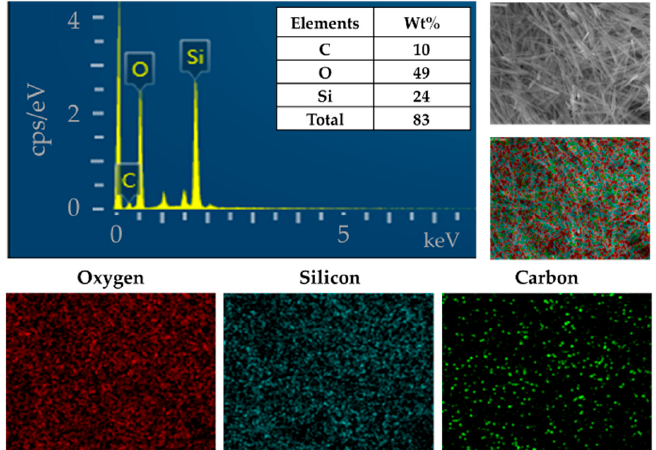
Figure 4. Energy dispersive spectrum (EDS) and elemental mapping images of SMWs.